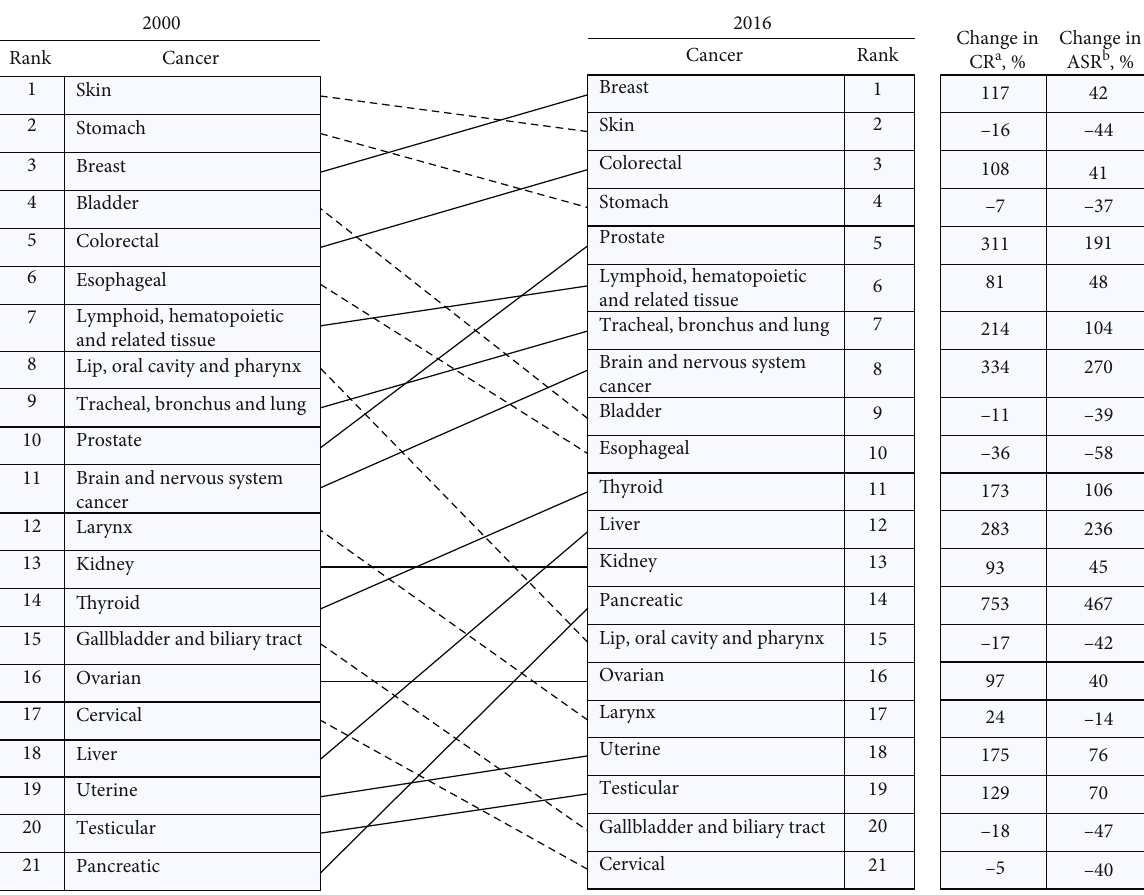
Figure 6: Cancers ranked for both sexes by national crude rate, including the percentage change in crude rate and the percentage change in the age-standardized rate between 2000 and 2016. The “ other cancer ” group is not included here because it contains multiple di ff erent types of cancers. Solid lines connecting the 2000 and 2016 charts indicate increased or unchanged rank for the connected cancers; dotted lines indicated decreased rank. a CR: crude rate; b ASR, age-standardized